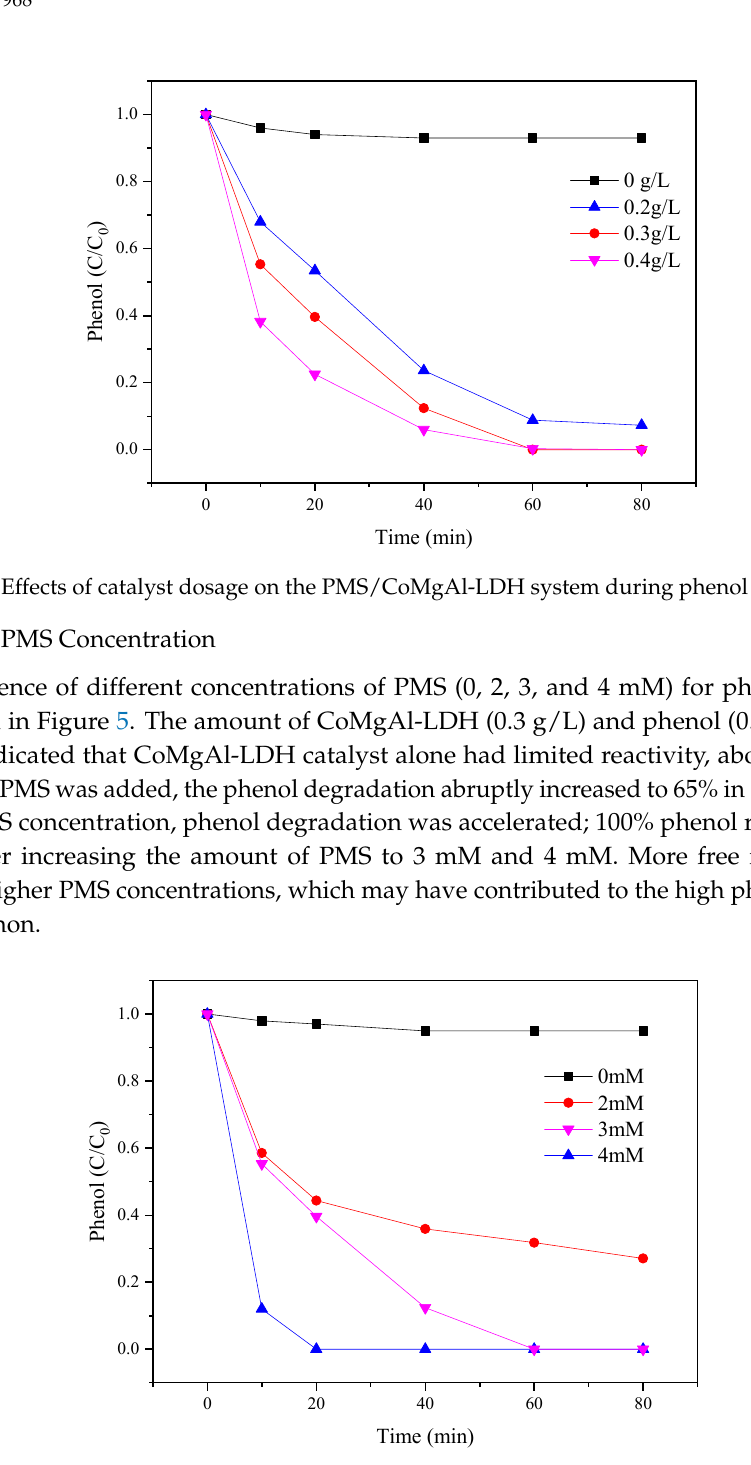
Figure 5. Effects of PMS concentration on the PMS/CoMgAl-LDH system during phenol degradation.